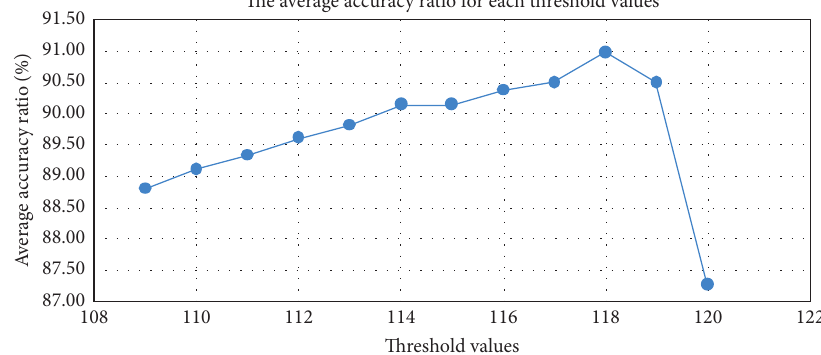
Figure 3: The plot between the average accuracy ratio of the eight selected locations and the threshold Algorithm 3. Haze warning system based on weighted choice values.